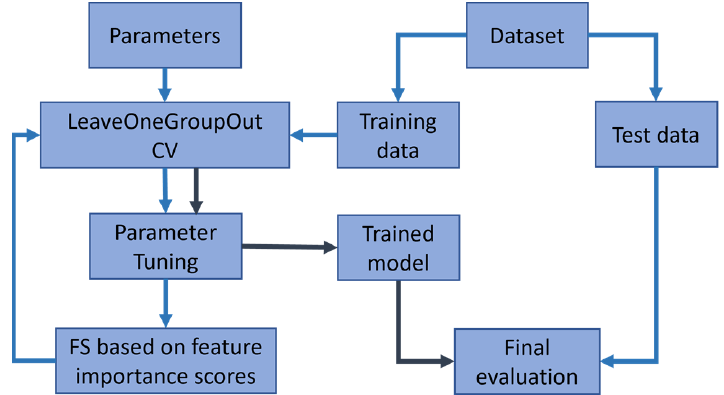
Figure 2. Flowchart for our Machine Learning training and prediction.